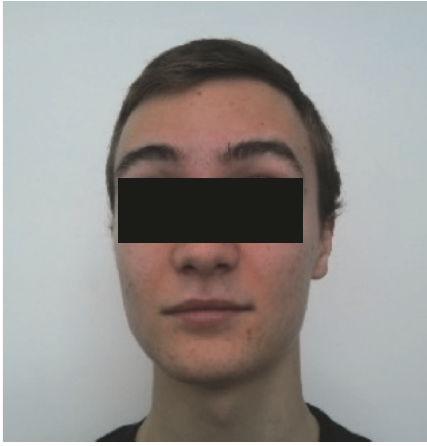
Figure 3: Resolved paralysis with normal brow elevation at week